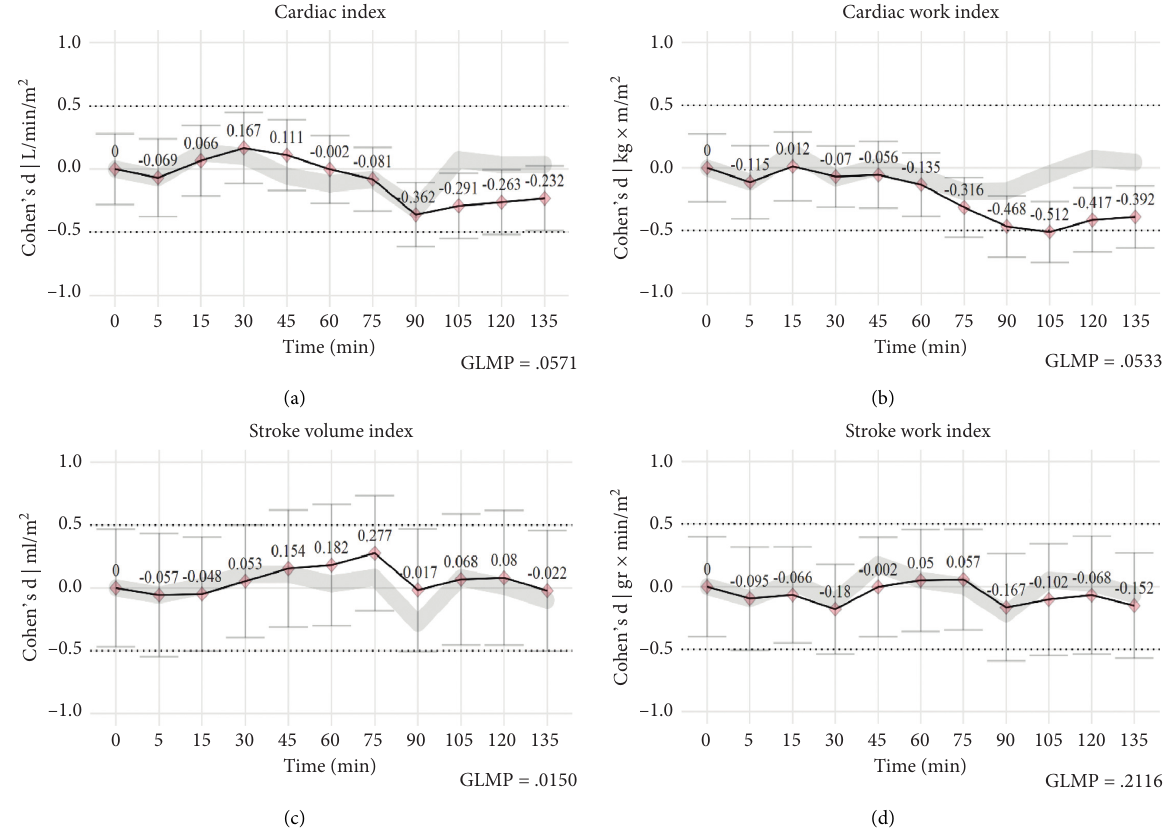
Figure 3: Effect size (Cohen’s d) assessment. The bold black line represents the changes (Cohen’s d) concerning the initial measurements; the differences between the time intervals are described in gray color. Cardiac index (a) undergoes small initial variations, secondary to vasodilation after epidural block and low variance afterward. At the end of the procedure, a moderate decrease in cardiac output was observed, which corresponds to the removal of the uterus from the systemic circulation. The cardiac work index (b) displayed more substantial changes at the end of the surgery. These fluctuations were followed by a mid-procedure stroke volume index adjustment (c). Despite these hemodynamic modifications, the stroke work index had (d) limited variation. Thus, we hypothesized that the noncardiac parts of the vascular system experience most of the adaptations, and the cardiac work investment is relatively the same for every